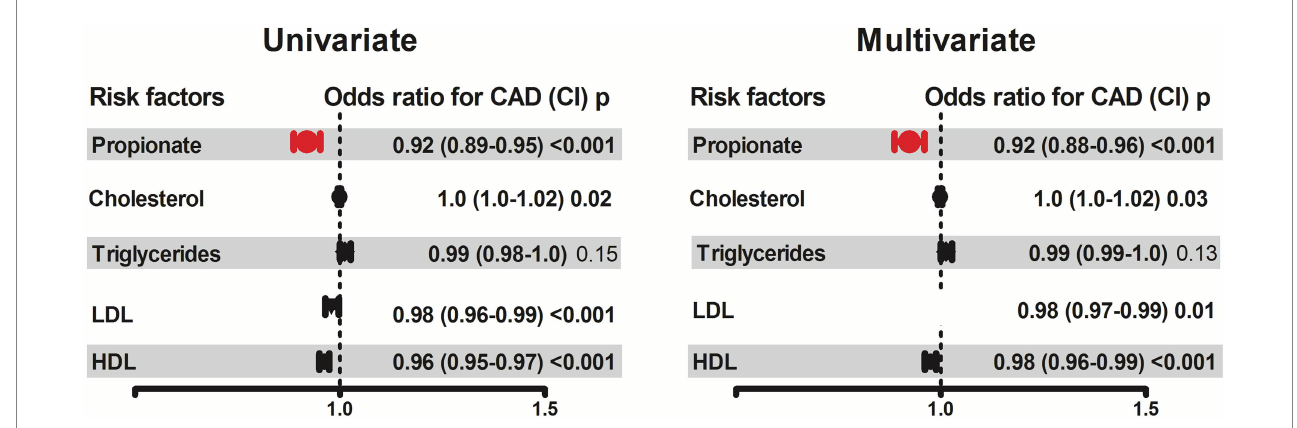
FIGURE 2 Association of propionate concentrations with the presence of coronary artery disease (CAD). The association of propionate with CAD was assessed by logistic regression using univariate and multivariate models adjusted for the major lipid parameters (HDL, LDL, Cholesterol, Triglycerides) in addition to age, gender, hypertension, diabetes and smoking. Odds ratios and 95% confidence intervals are presented. Odds ratios for continuous variables are per 1-SD